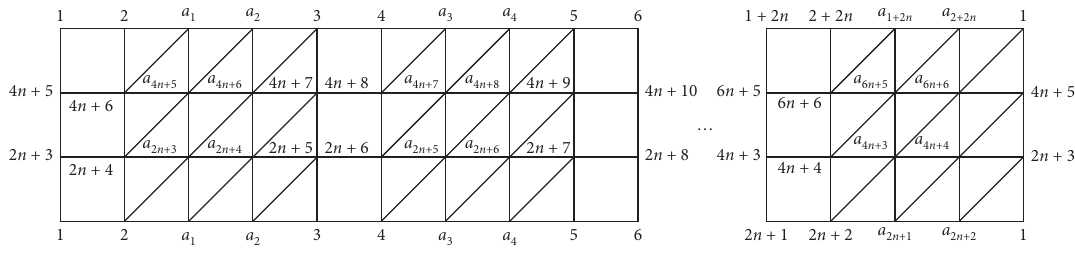
Figure 14: DSEM of type- [ 3 6 : 3 3 , 4 2 ]